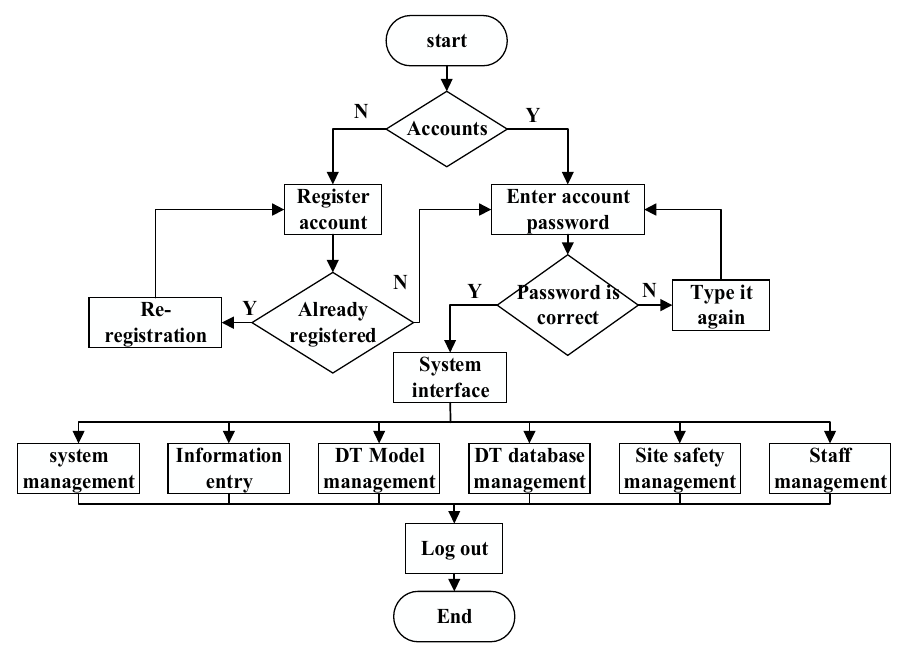
Figure 12. LoRa gateway installed on the construction site.